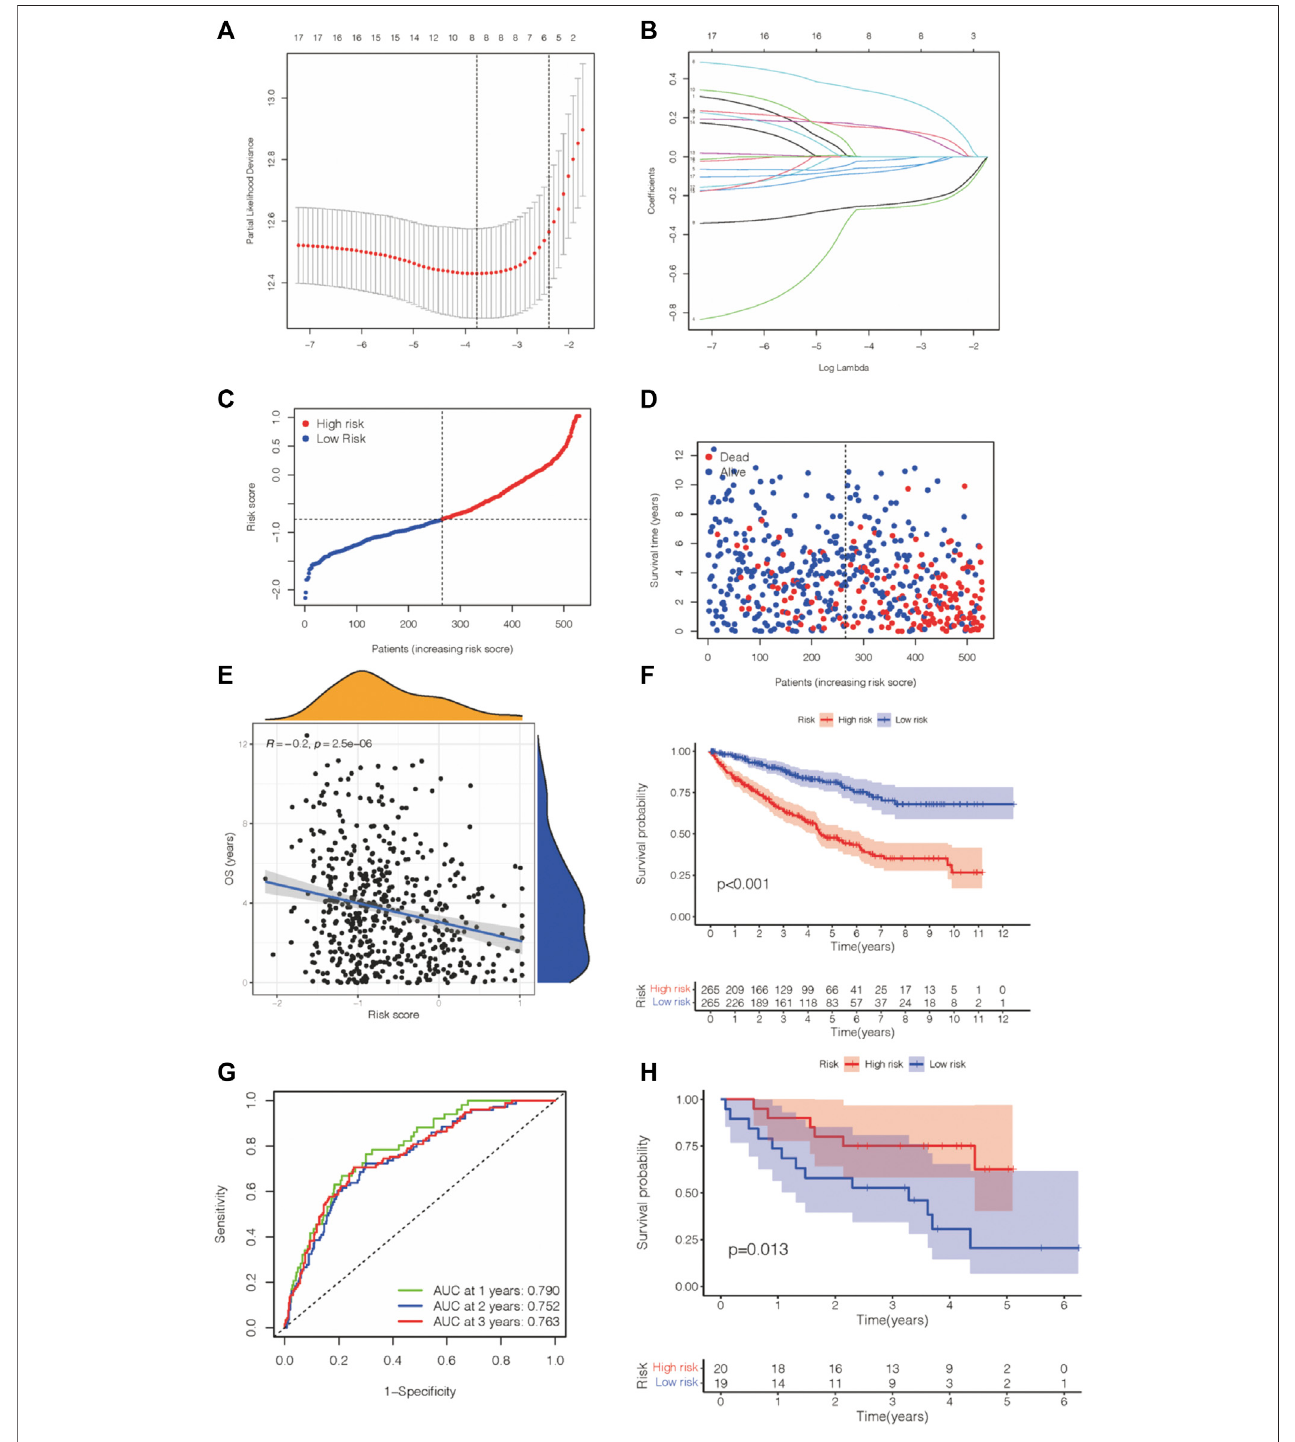
FIGURE 4 | IGPM-based prognosis panel was constructed and veri fi ed. (A , B) LASSO-Cox regression analysis was applied to construct the prediction model for ccRCC prognosis. (C , D) Risk value and survival information were shown in KIRC. (E) Correlation analysis of the risk value and survival time in KIRC. (F) Kaplan – Meier survivalanalysisoftheKIRCandgenepanel. (G) TheAUCscoreoftheaccuracyofthepredictiveprognosispanelforKIRC. (H) Kaplan – Meiersurvivalanalysisofthegene panel was conducted in GSE29609.